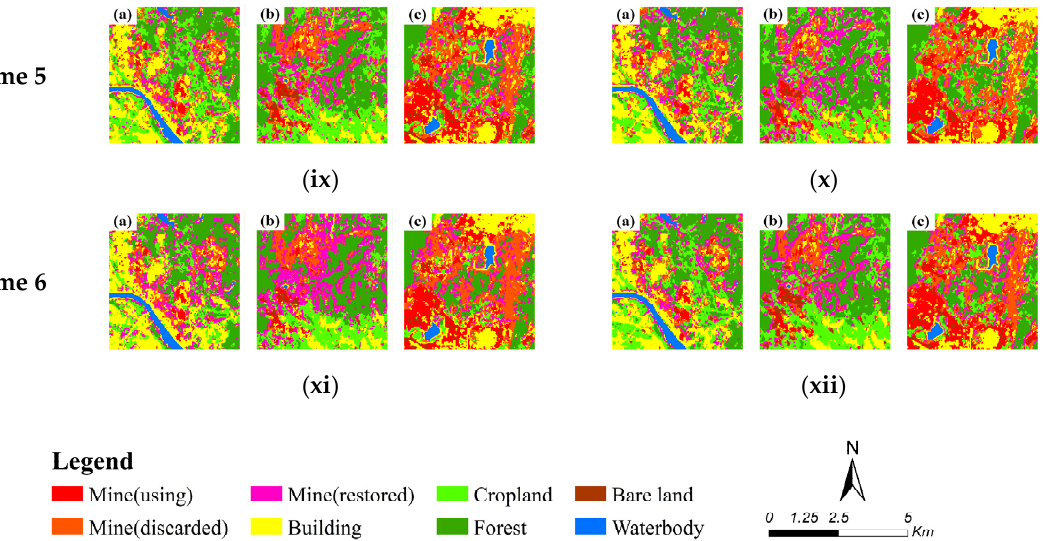
Figure 13. Comparison of classifications from: ( i ) Scheme 1 by SVM, ( ii ) Scheme 1 by RF, ( iii ) Scheme 2 by SVM, ( iv ) Scheme 2 by RF, ( v ) Scheme 3 by SVM, ( vi ) Scheme 3 by RF, ( vii ) Scheme 4 by SVM, ( viii ) Scheme 4 by RF, ( ix ) Scheme 5 by SVM, ( x ) Scheme 5 by RF, ( xi ) Scheme 6 by SVM, ( xii ) Scheme 6 by RF; ( a ), ( b ), ( c ) represent the selected northern, middle and southern mineral exploiting area in the study field, respectively.